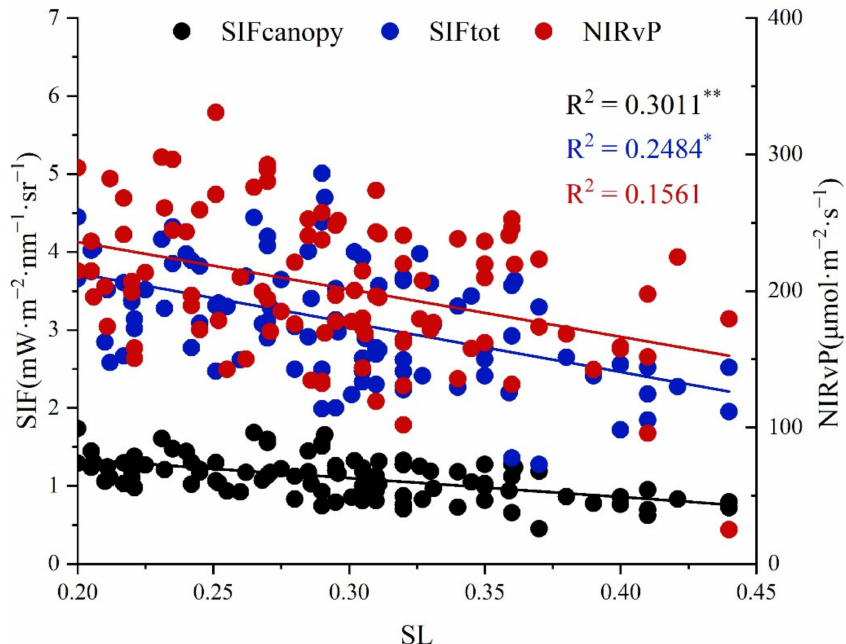
Figure 6. Overview of the relationships between the severity level (SL) and SIF canopy -related variables at a moderate stage of disease onset ( n = 99). Where ** indicates extremely significance at p < 0.001 level, * indicates extremely significance at p < 0.05